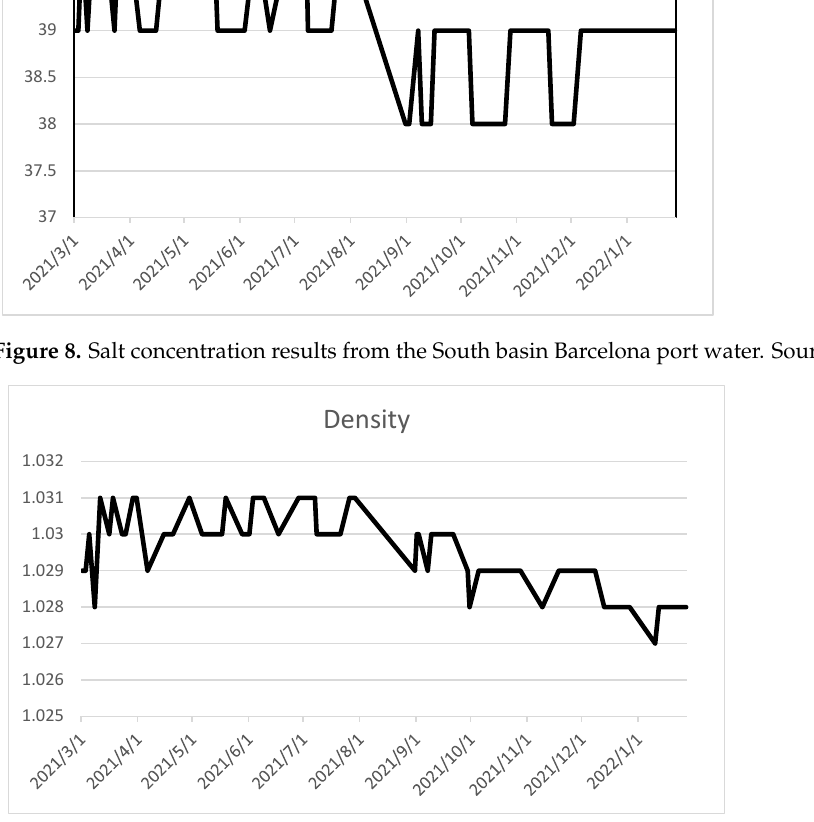
Figure 9. Diagram of density results from the South basin Barcelona port water. Source: The au- thors. In the case of the salt concentration and port water density, all the variations ob- served were mainly due to the frequency, intensity and duration of precipitation, alt- hough also to a lesser extent by the frequency of ships calling into the South Basin of the Barcelona port using open-loop exhaust-gas cleaning systems.